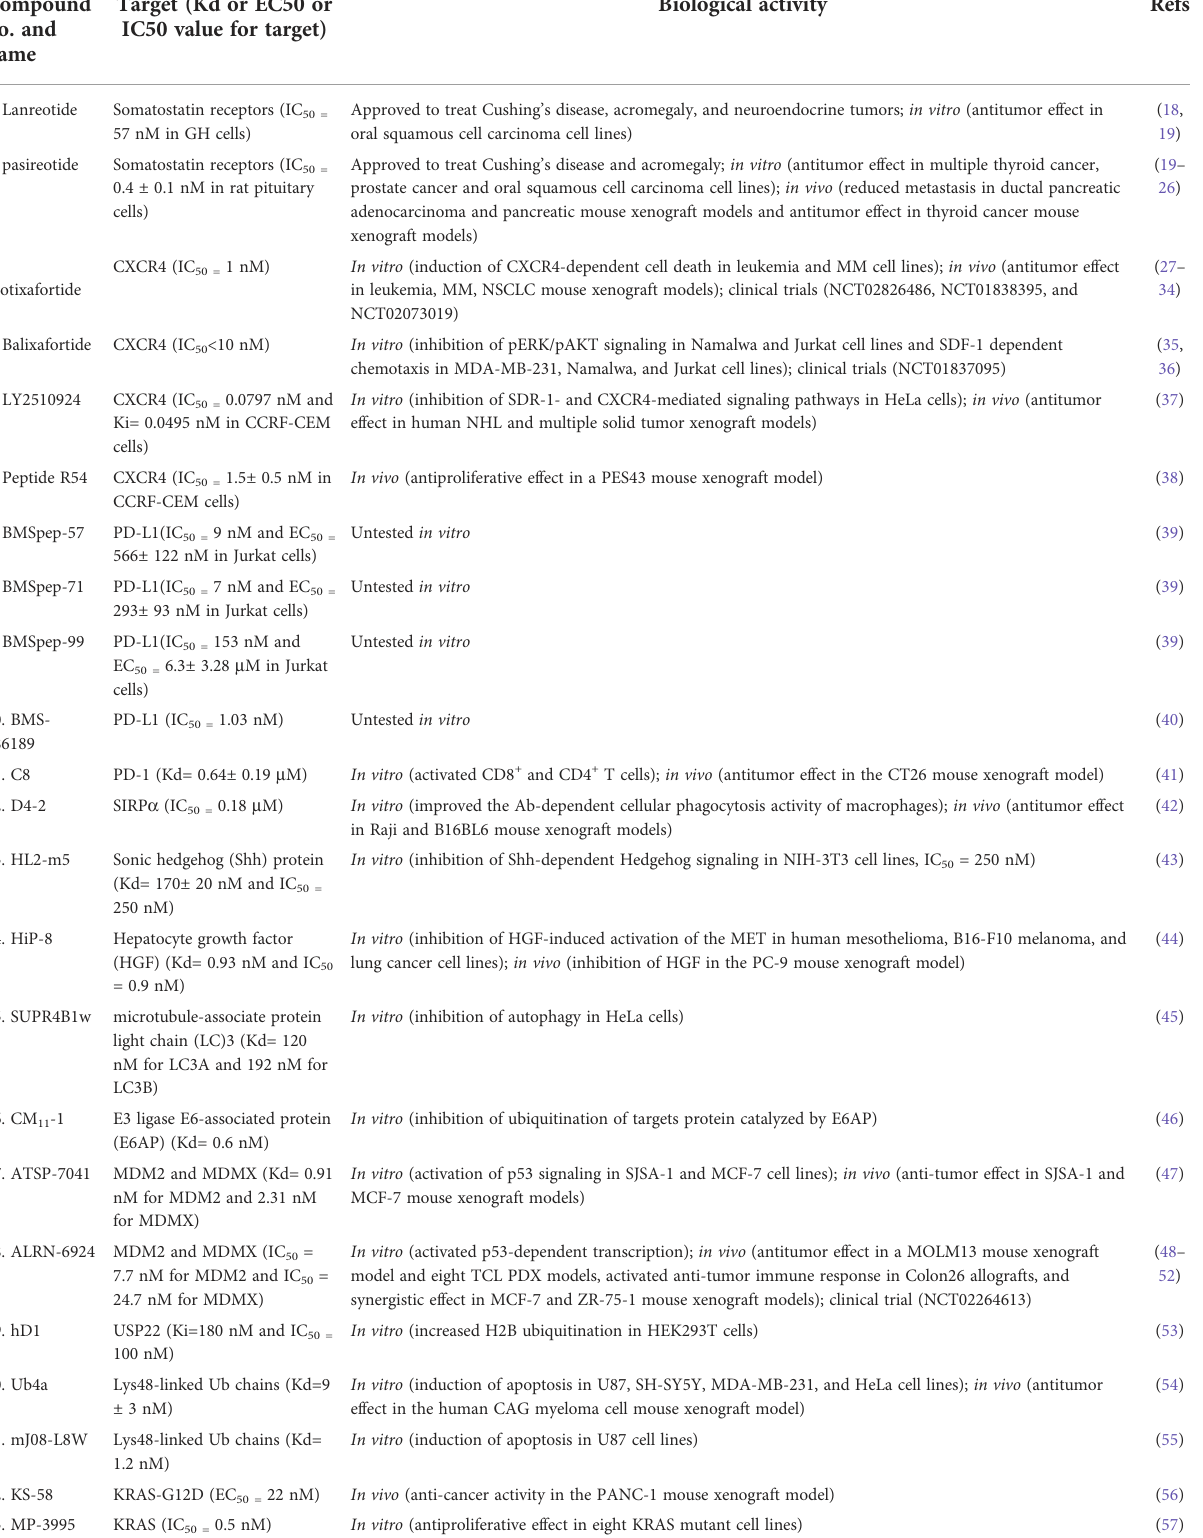
TABLE 4 Examples of macrocyclic